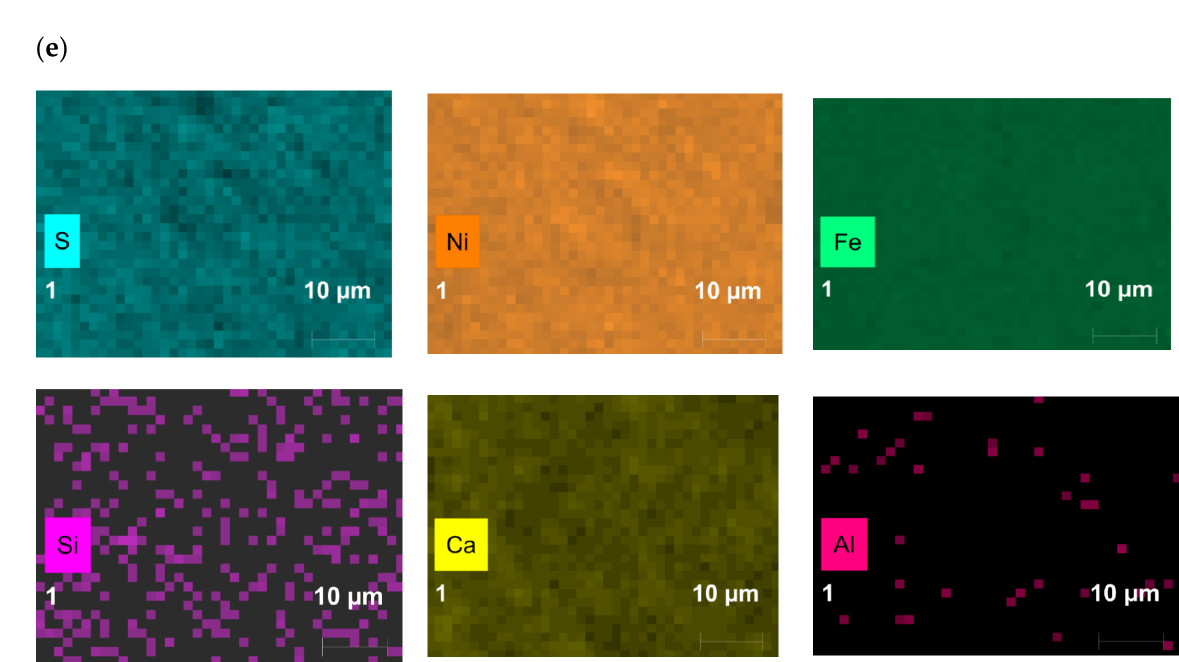
Figure 3. The distribution of elements in the catalysts isolated after thermo-catalytic treatment for ( a ) 1 h; ( b ) 2 h; ( c ) 4 h; ( d ) 6 h; ( e ) 12 h.